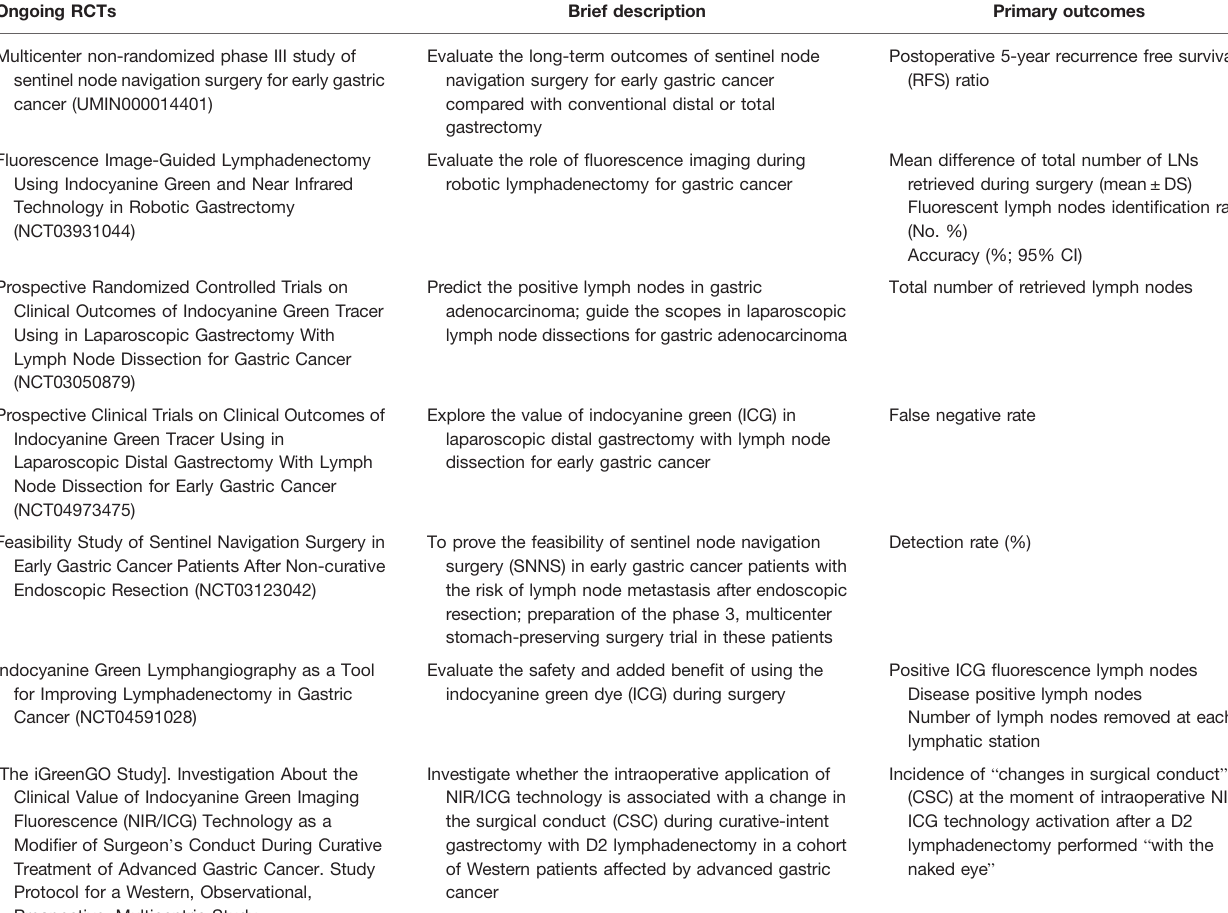
TABLE 2 | Ongoing randomized clinical